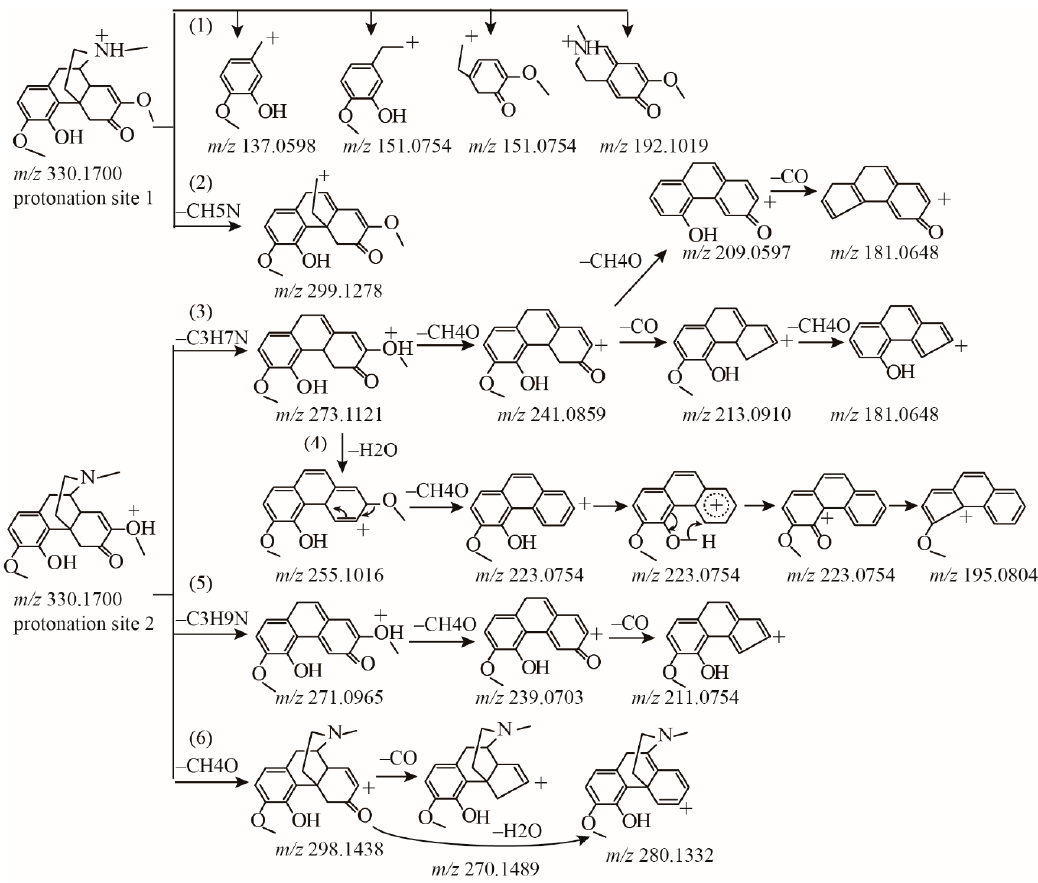
Figure 3. Proposed fragmentation pattern of the protonated sinomenine.